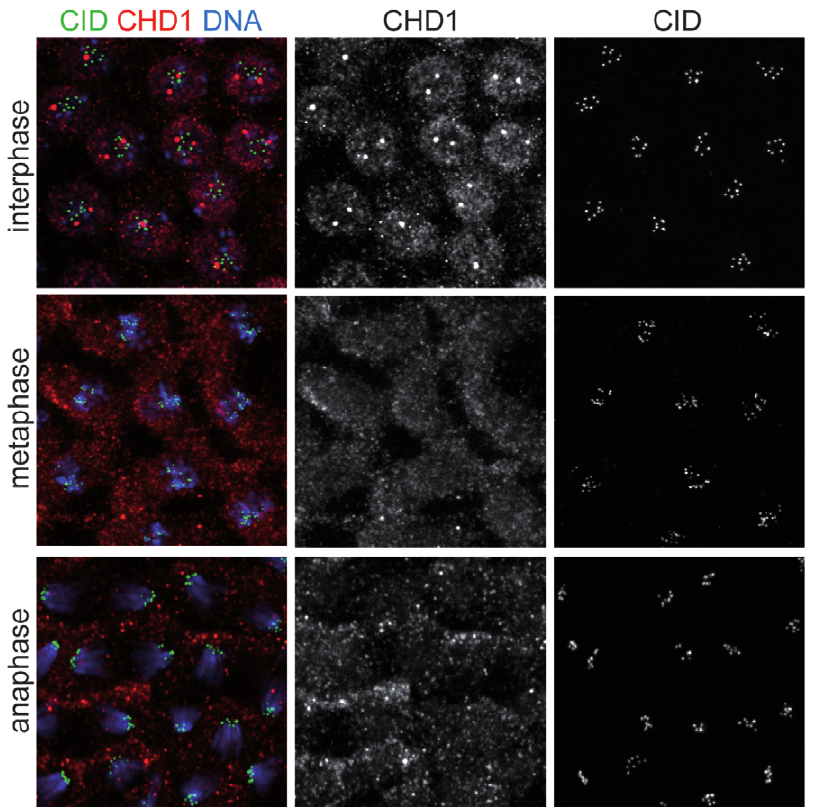
Figure 2. CHD1 and CenH3 CID do not colocalize in Drosophila embryos. Embryos laid by transgenic female flies expressing EGFP-tagged CenH3 CID [11] were collected at 0–2 h after egg deposition and stained with antibodies against CHD1 (red) and GFP (green) to detect EGFP-CenH3 CID . DNA was stained with DAPI (blue). Three syncytial embryos with interphase, metaphase and anaphase nuclei, respectively, are shown. CHD1 does not colocalize with centromeres at any cell cycle stage.